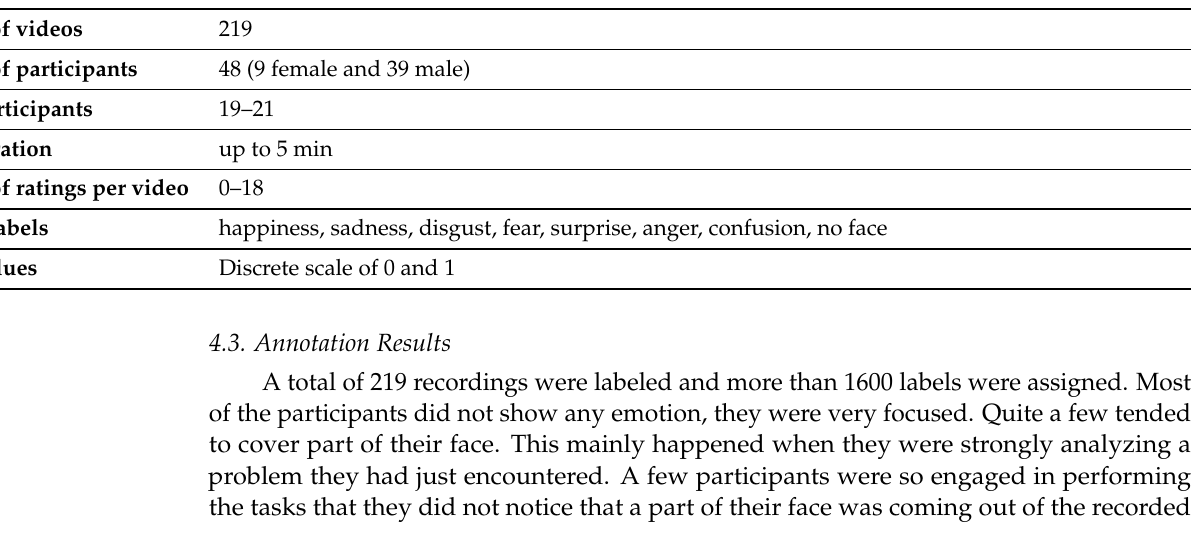
Table 2. Summary of data subjected to